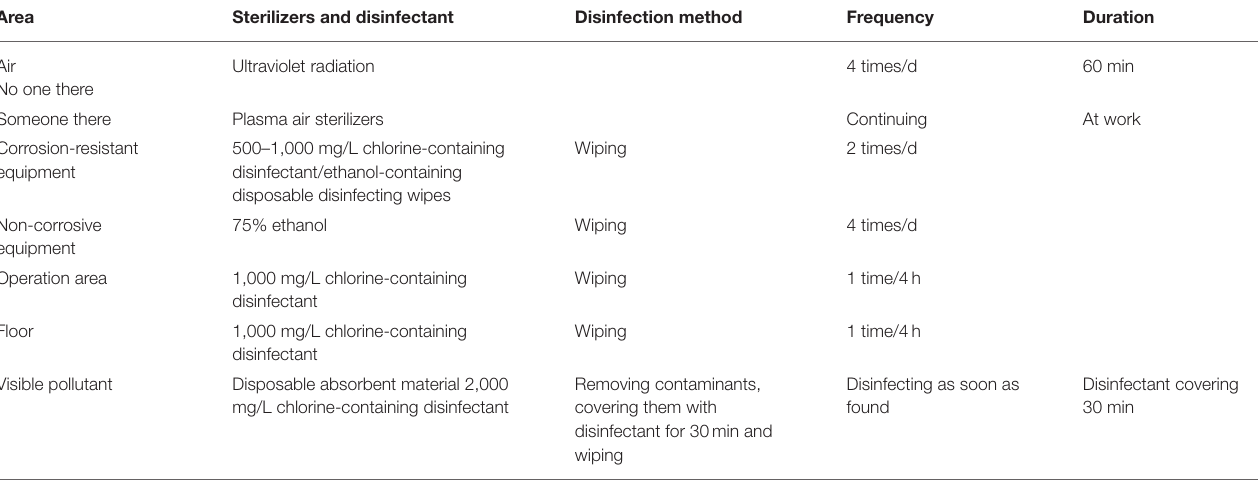
TABLE 1 | The selection and guidance of the sterilizers and disinfectants.